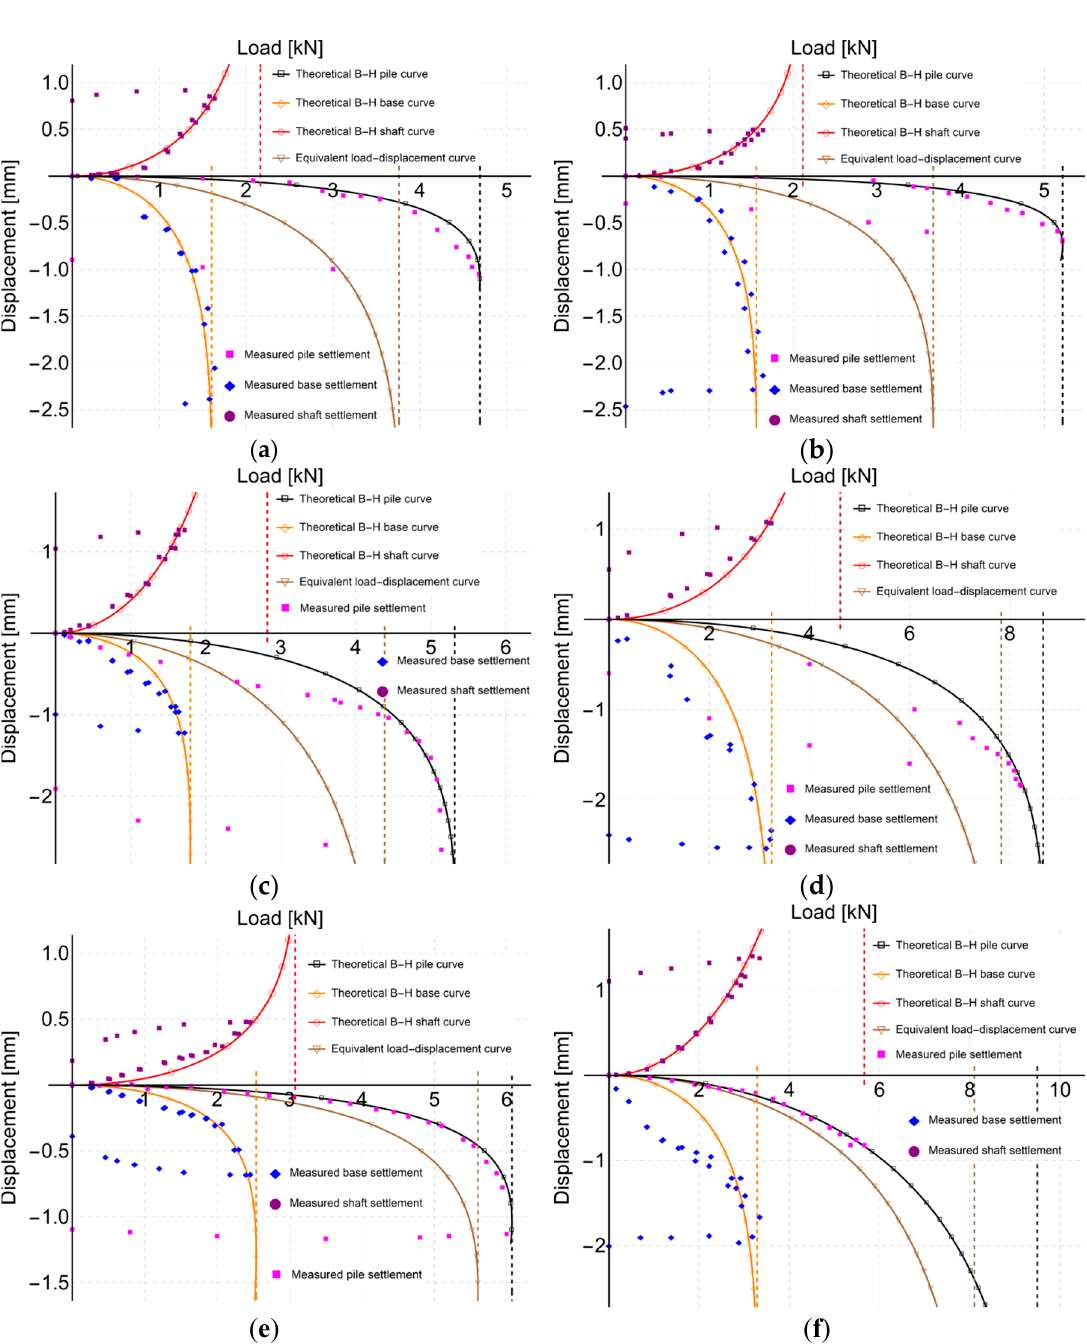
Figure 11. Test results for standard static loads and bi-directional tests including the resultant equivalent curve: ( a ) pile 1. ( b ) pile 2. ( c ) pile 3. ( d ) pile 4. ( e ) pile 5. ( f ) pile 6.